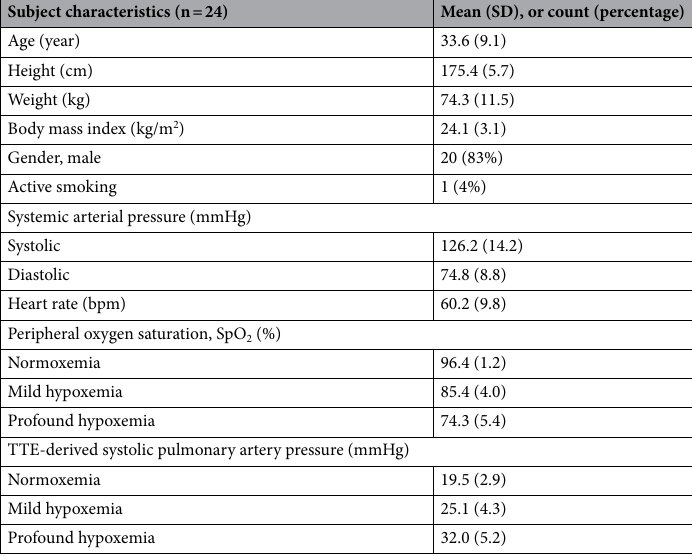
Table 1. Biometric characteristics of the 24 participants. The data are given as “mean (standard deviation, SD)”, or as “count (percentage)” when indicated. For peripheral oxygen saturation (SpO 2 ) and systolic pulmonary artery pressure, the data are provided as a function of the saturation level: normoxemia